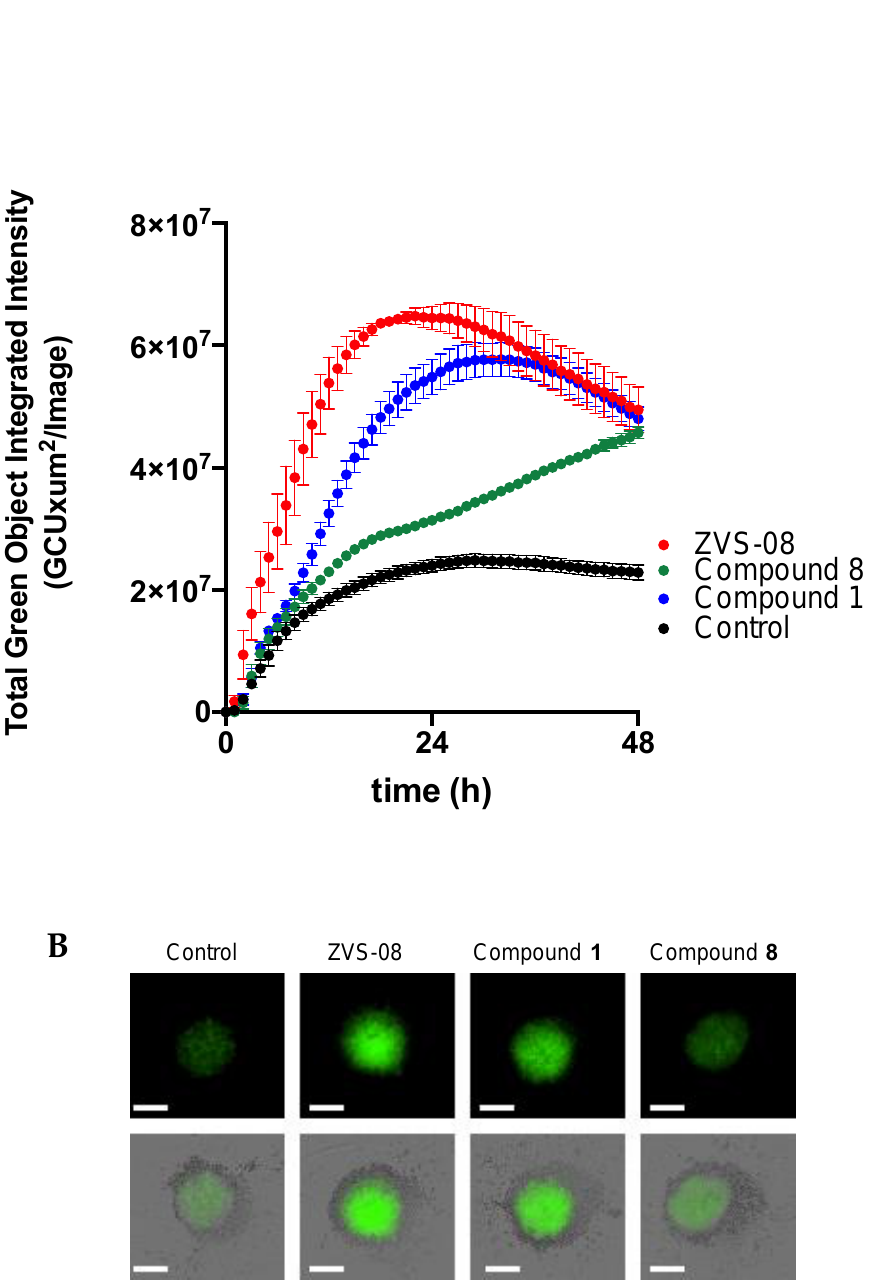
Figure 15. ( A ) Apoptosis induction by ZVS-08 and compounds 1 and 8 (50 µM) on tumour spheroids formed by Colo 357 cells. ZVS-08 was markedly faster and compound 8 was slowest. Data represent mean ± standard error ( N = 3). ( B ) Representative images of spheroids 24 h after the addition of the indicated compounds (50 µM). Fluorescence intensity in the upper image corresponds to cleavage of the caspase 3/7 activity reporter; it has been merged with the phase contrast image in the lower raw. Scale bar: 400 µm.